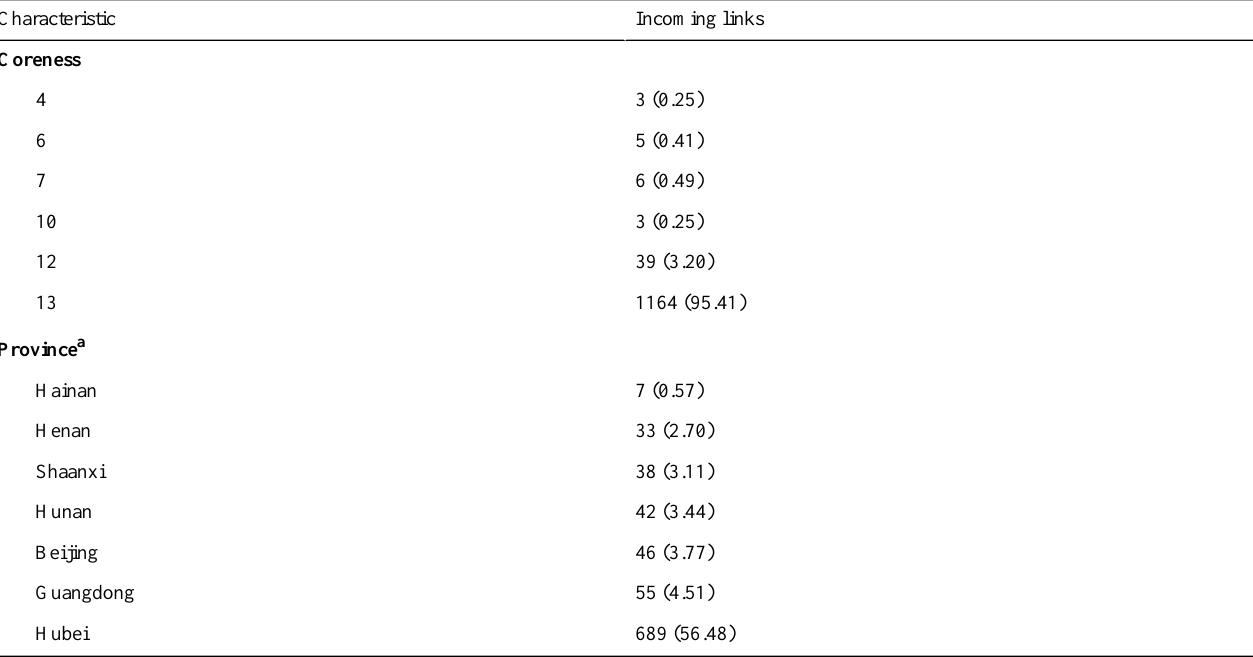
Table 1. Comparison of the out-strengths of each shell (coreness) and the innermost nodes (provinces) based on the COVID-19 epidemic network in the study period (N=1246 links), n